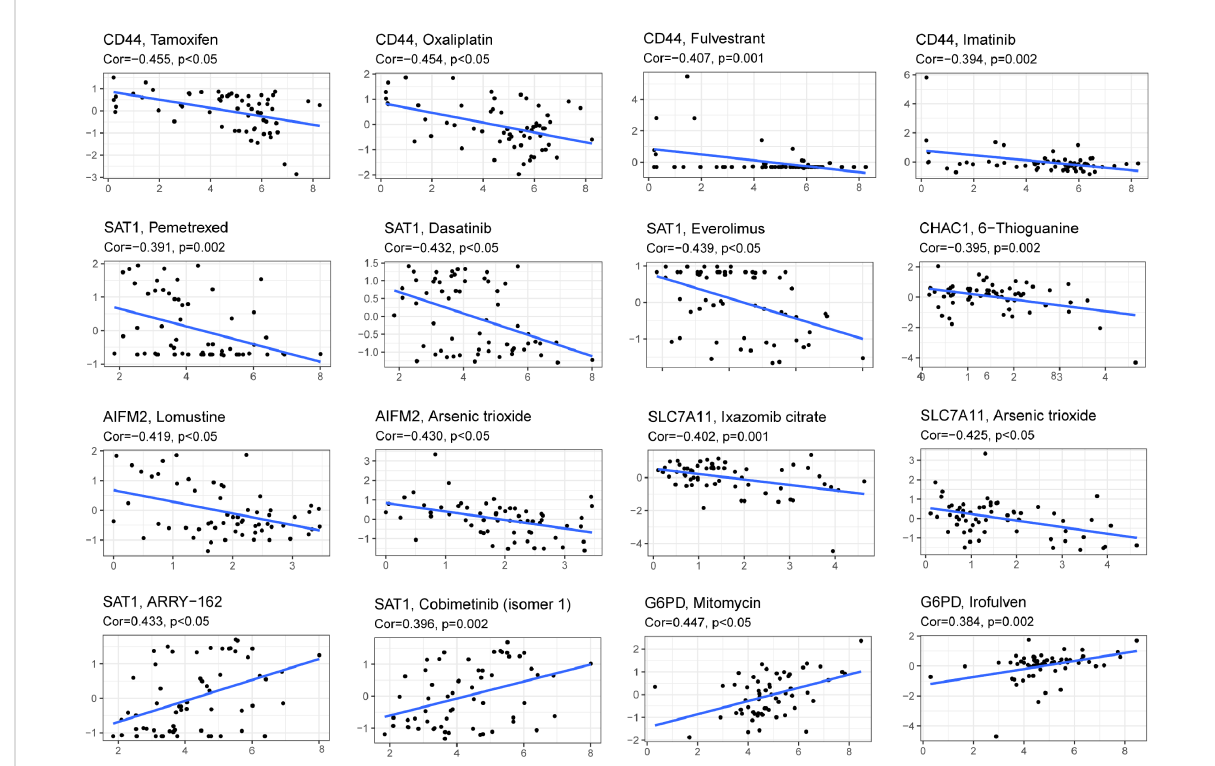
FIGURE 9 Drug sensitivity analysis of the 10-gene signature. (Cor > 0 means that patients with high expression of this gene may be sensitive to this drug; Cor< 0 means that patients with high expression of this gene may be resistant to this drug. P <